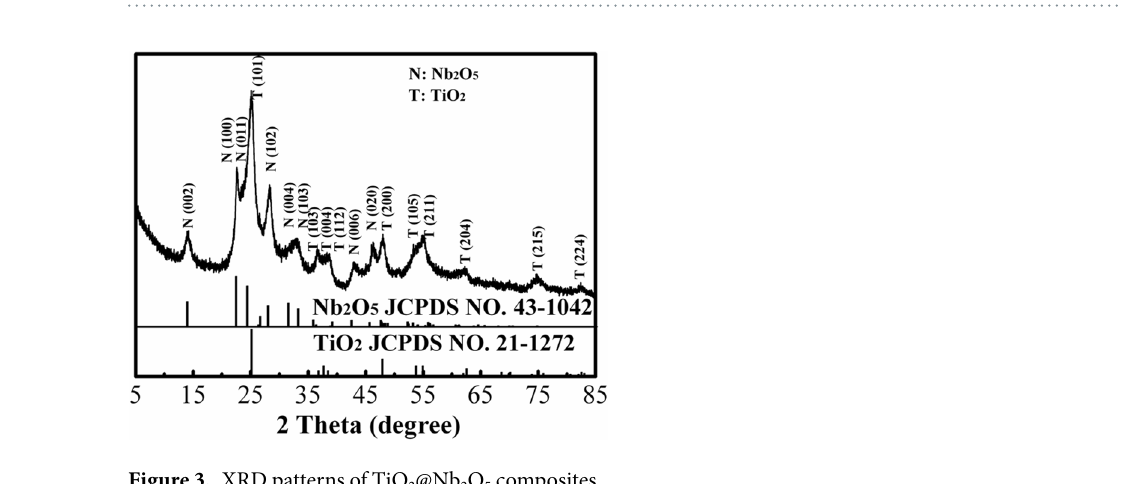
Figure 3. XRD patterns of TiO 2 @Nb 2 O 5